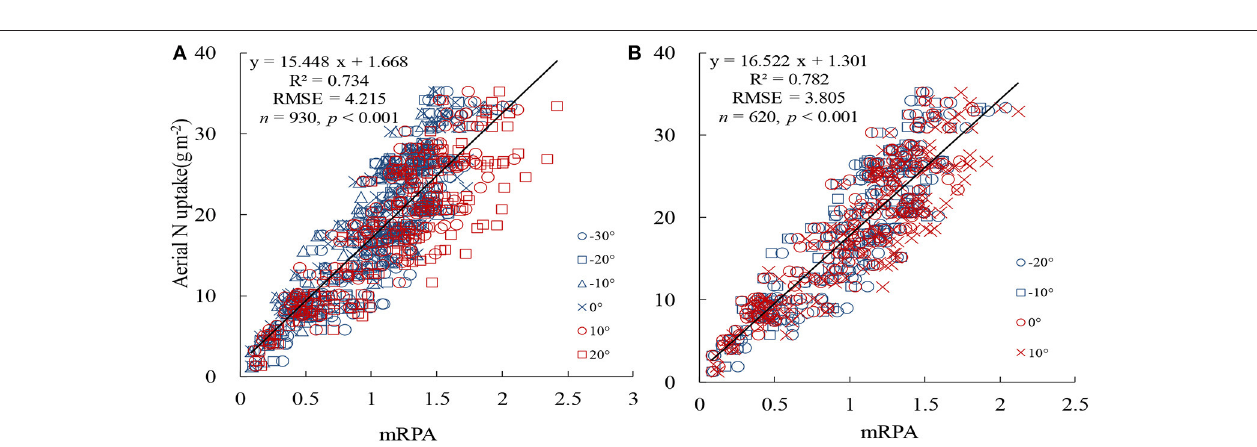
FIGURE 12 | Comparison of the prediction power of mRPA at different VZA combinations in terms of aerial N uptake. (A) − 30 ◦ to + 20 ◦ and (B) − 20 ◦ to + 10 ◦ .